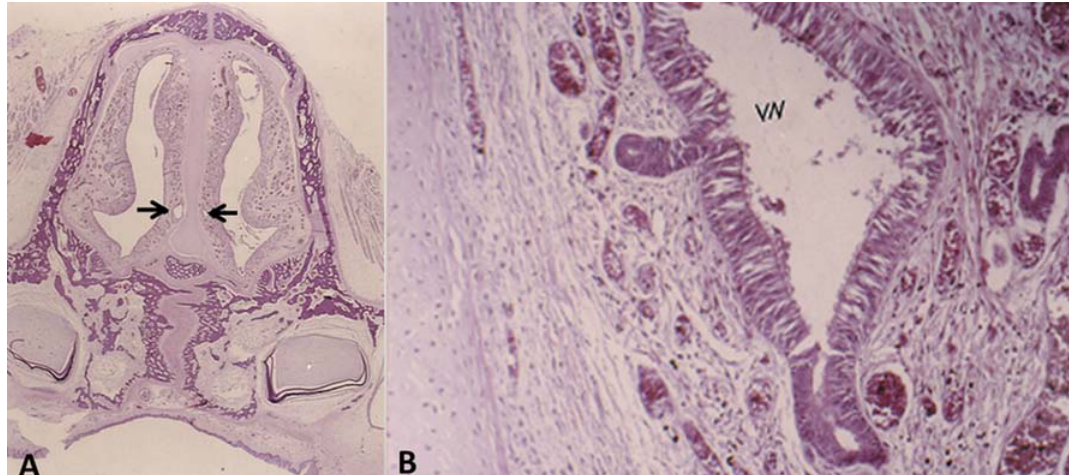
Figure 2- (cid:2) (cid:26)(cid:9)(cid:16)(cid:18)(cid:2) (cid:16)(cid:14)(cid:13)(cid:2) (cid:14)(cid:16)(cid:6)(cid:16)(cid:18)(cid:2) (cid:20)(cid:16)(cid:25)(cid:17)(cid:5)(cid:27)(cid:2) (cid:6)(cid:15)(cid:11)(cid:28)(cid:17)(cid:14)(cid:19)(cid:2) (cid:6)(cid:5)(cid:9)(cid:16)(cid:5)(cid:17)(cid:24)(cid:8)(cid:13)(cid:2) (cid:7)(cid:16)(cid:9)(cid:16)(cid:29)(cid:8)(cid:9)(cid:16)(cid:5)(cid:17)(cid:14)(cid:17)(cid:30)(cid:8)(cid:13)(cid:2) (cid:6)(cid:31)(cid:4)(cid:16)(cid:12)(cid:11)(cid:4)(cid:6)(cid:2) (cid:8)(cid:7)(cid:17)(cid:5)(cid:15)(cid:8)(cid:18)(cid:17)(cid:16)(cid:18)(cid:2) (cid:16)(cid:14)(cid:13)(cid:2) (cid:7)(cid:6)(cid:8)(cid:4)(cid:13)(cid:11)!(cid:6)(cid:5)(cid:9)(cid:16)(cid:5)(cid:17)(cid:24)(cid:8)(cid:13)(cid:2) (cid:20)(cid:17)(cid:18)(cid:17)(cid:16)(cid:5)(cid:8)(cid:2) columnar epithelial tissue. Presence of connective tissue and bone tissue in process of neoformation. The nasal septum in the central portion of the premaxilla and tooth buds in the bell stage. Bilateral vomeronasal organ (arrows)